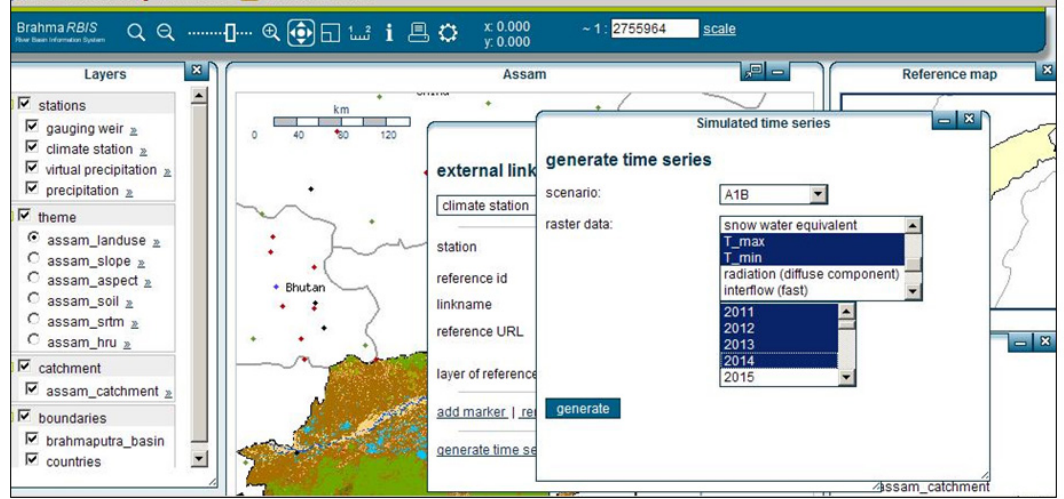
Figure 5. Extracting downscaled data time series from grid cells of a model domain.